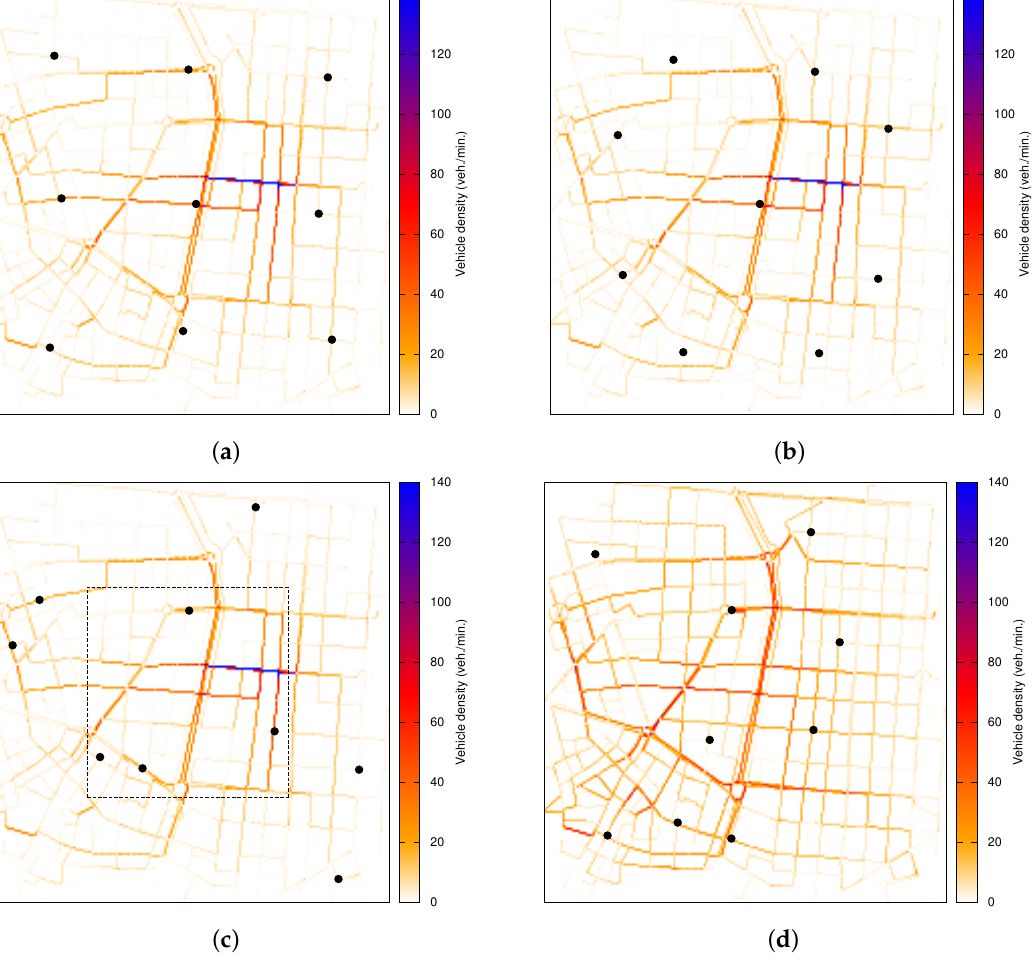
Figure 10. Comparison of the different RSU deployment policies for nine RSUs: Madrid scenario. ( a ) Geographic approach; ( b ) Density-based Road Side Unit deployment policy (D-RSU); ( c ) GARSUD with a central downtown; ( d ) GARSUD uniform traffic flow (i.e., without any